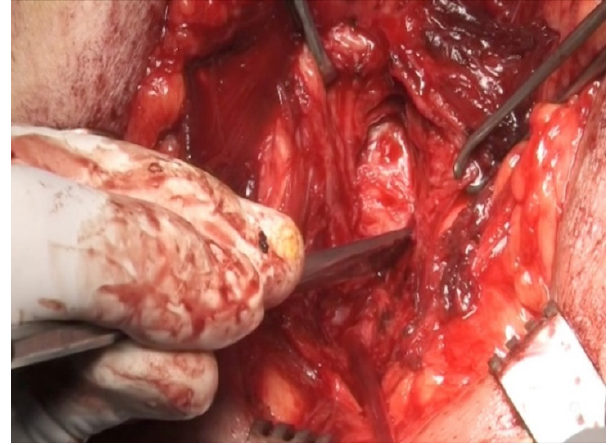
Figure 2. ( A , B ) Corporal body separation.